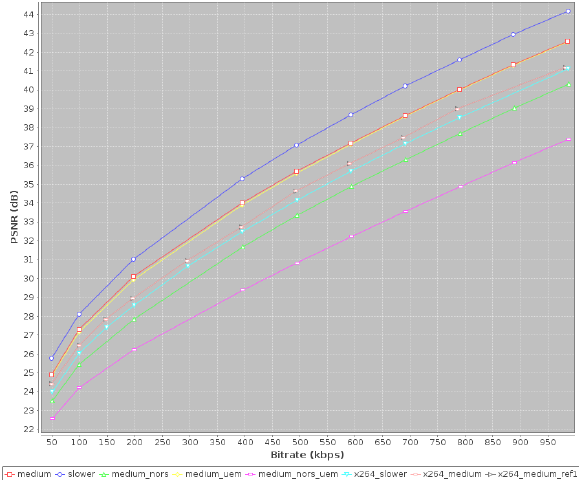
Figure 12: R-D curves for the ”Rome” sequence, with a resolu- tion of 1088x672 pixels and a frame rate of 0.5 fps.